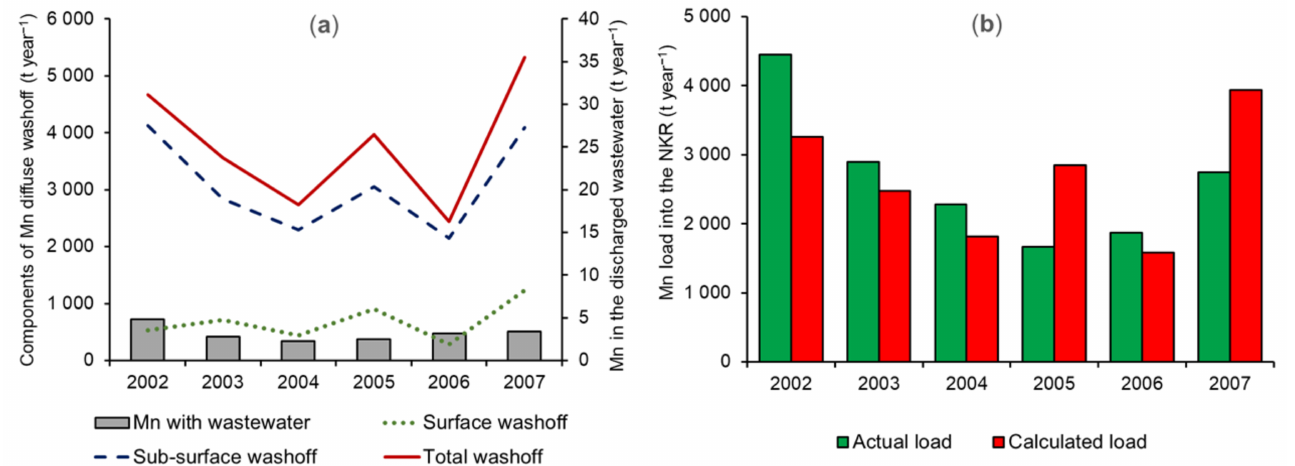
Figure 6. Inter-annual dynamics: ( a ) Simulated components of Mn load in the river network; ( b ) The actual and calculated Mn load in the